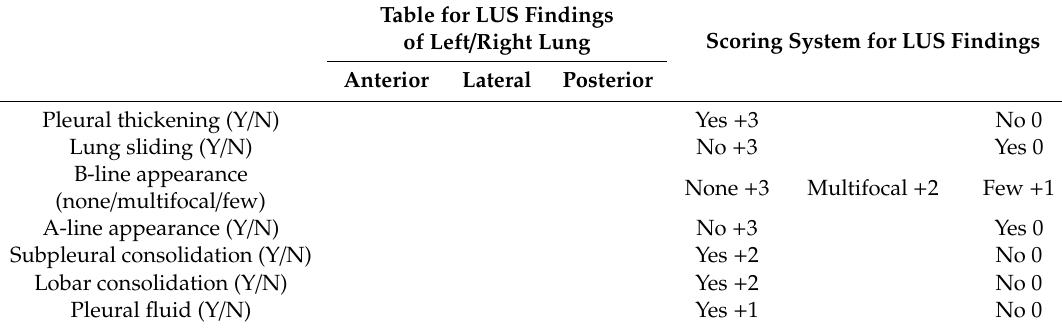
Table 1. Table for LUS findings according to lung zones, along with a constructed scoring system for observed lung changes. Table for LUS Findings of Left / Right Lung Scoring System for LUS Findings Anterior Lateral